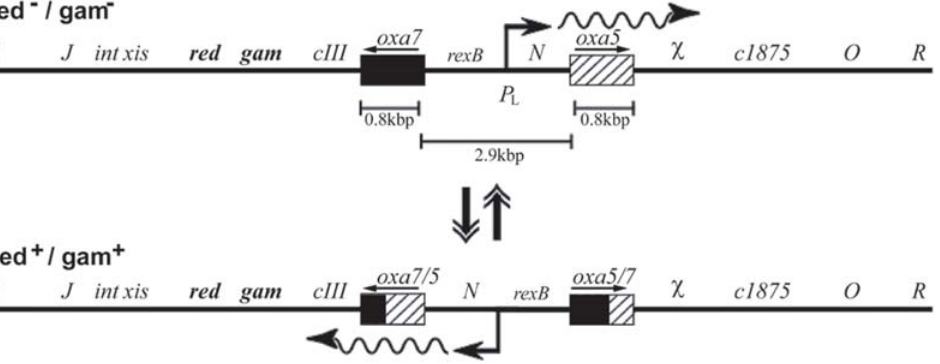
Figure 1. Recombination between the two homeologous oxa sequences flanking the l pL promoter leads to a phenotypic switch. In l red - gam -, transcription from the pL promoter proceeds rightward and the red and gam genes are not transcribed. Recombination between the two homeologous sequences leads to inversion of the pL-N segment causing a selectable phenotype (see Text for details). Not drawn to scale.